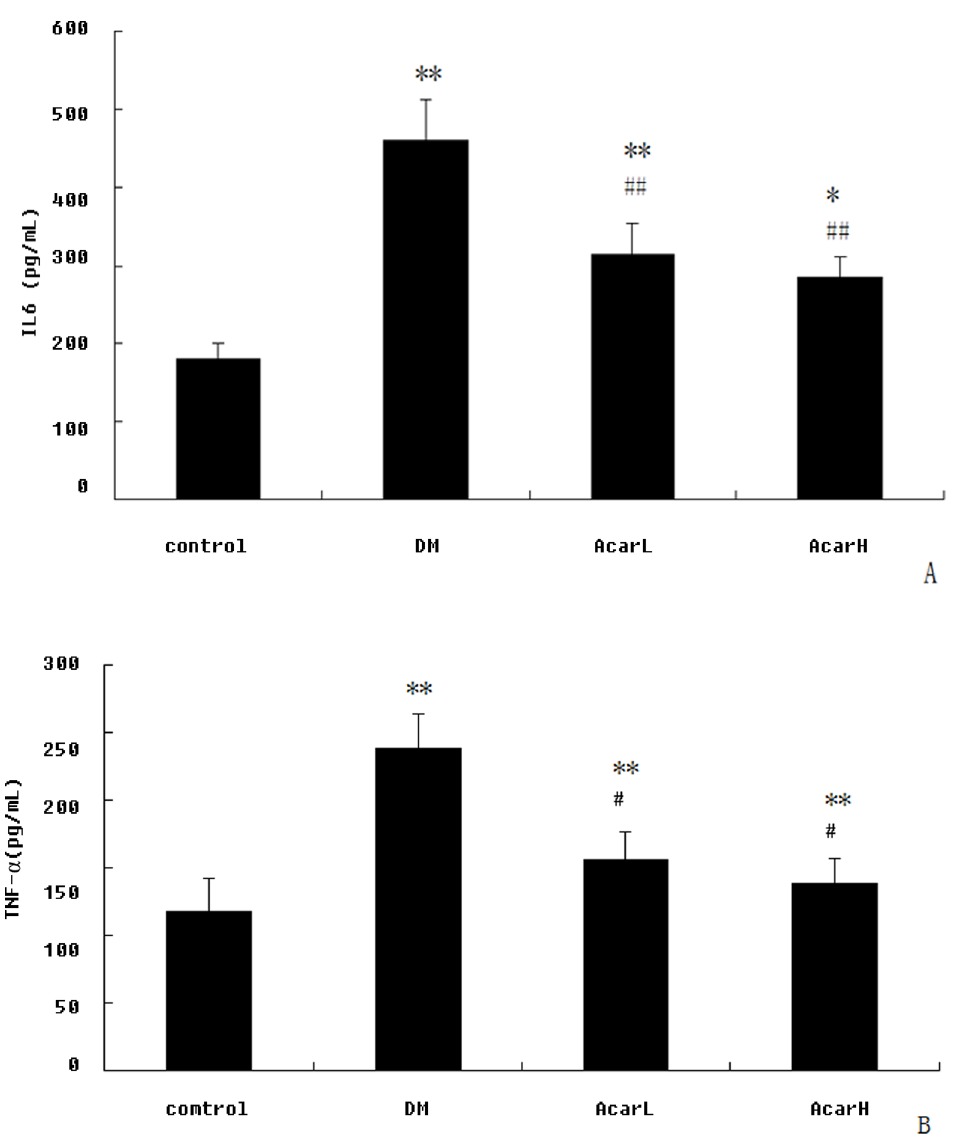
Figure 3. The effect of acarbose on serum IL6 (A) and TNF- a (B) in rats (n=10 per group). Data represent mean 6 SD (n=10). ** P , 0.01 versus the control group; ## P , 0.01 versus DM group.